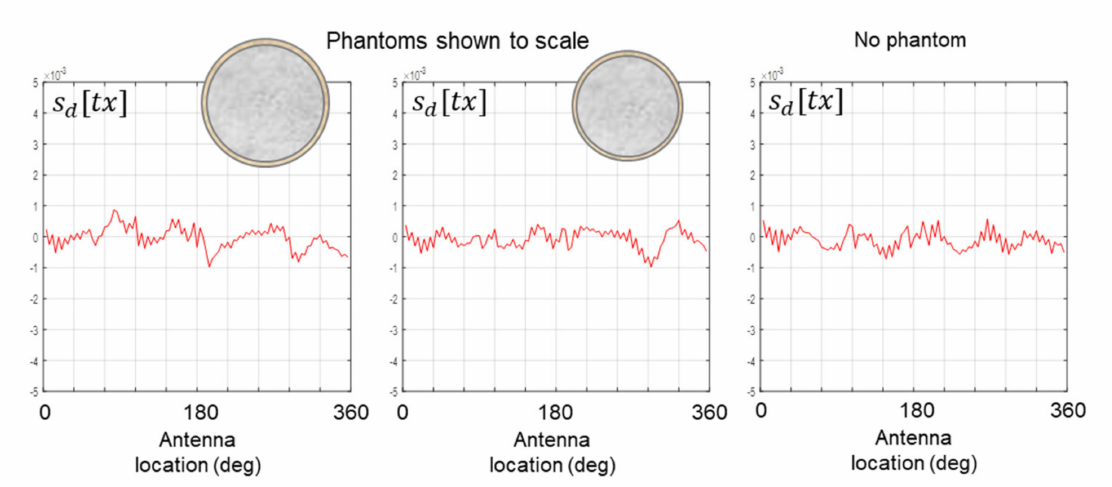
Figure 16. Data from scans of the 175 mm and 150 mm phantoms with no stroke inclusion present, and a scan of just the scanning